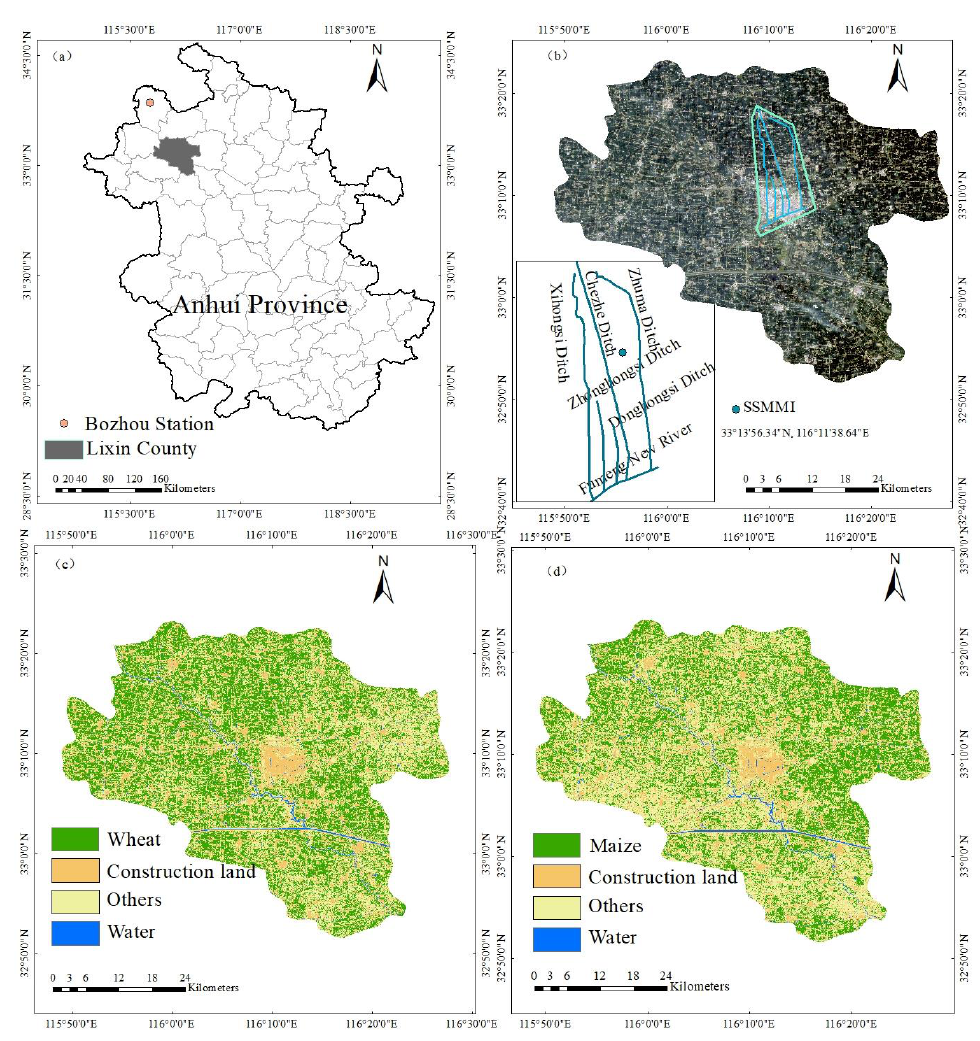
Figure 1. Study area. ( a ) Location of Lixin County; ( b ) Location of the smart soil moisture monitoring instrument (SSMMI); ( c ) Crop classification map of wheat; ( d ) Crop classification map of maize.